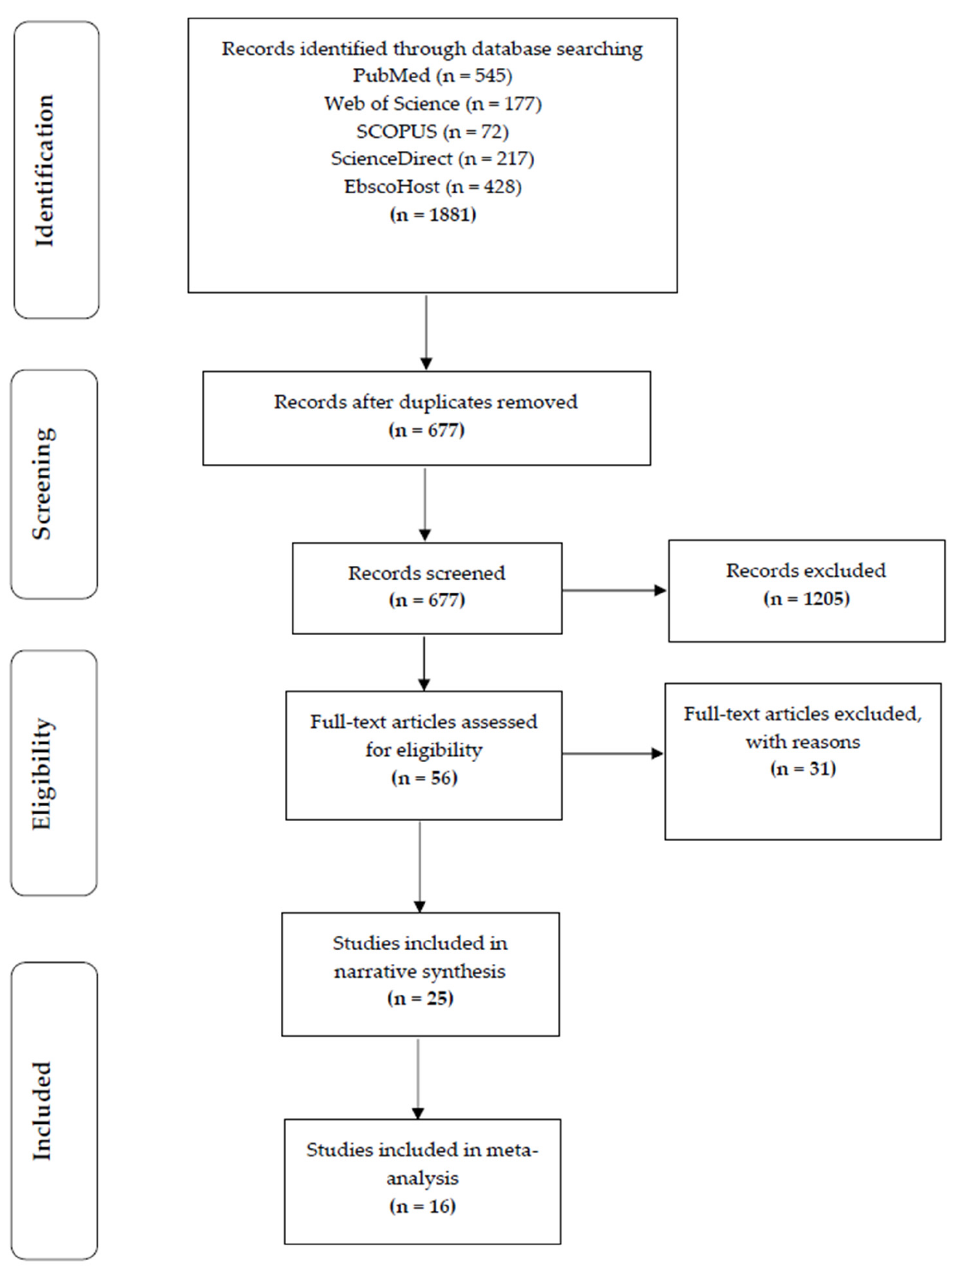
Figure 1. Flow chart of study selection in narrative review [62].